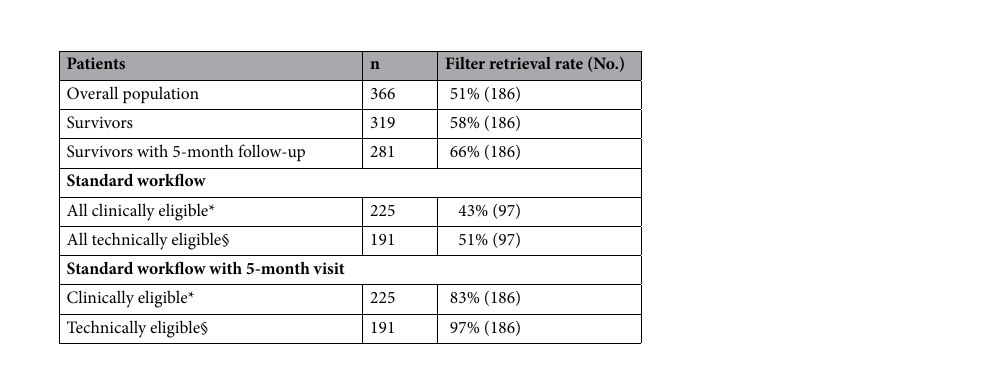
Table 3. Retrieval rates achieved at different stages of the study. *p value < 0.001. § p value <